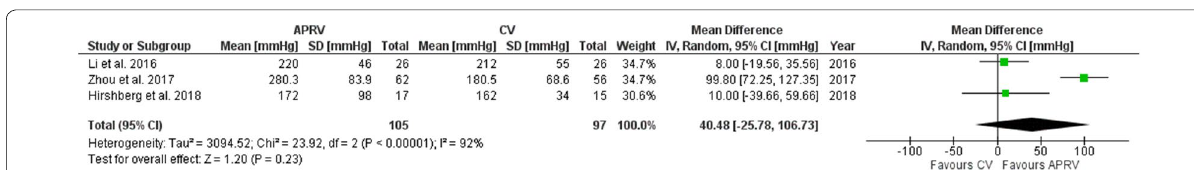
Fig. 5 PaO 2 /FiO 2 at day 3. APRV airway pressure release ventilation, CV conventional ventilation